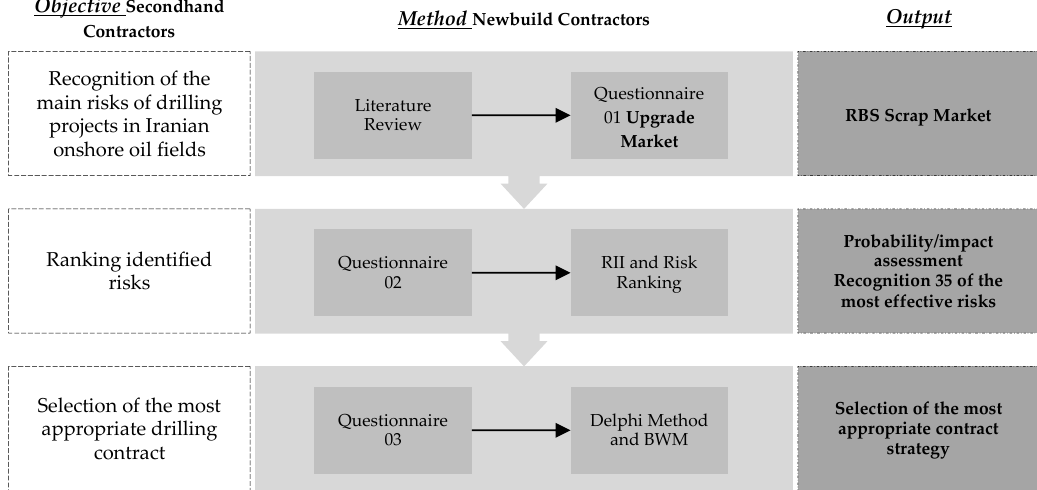
Figure 2. Objectives, methods, and outputs in each stage of the research methodology. Table 1. The comparison scale of the Analytical Hierarchy Process (AHP) method.